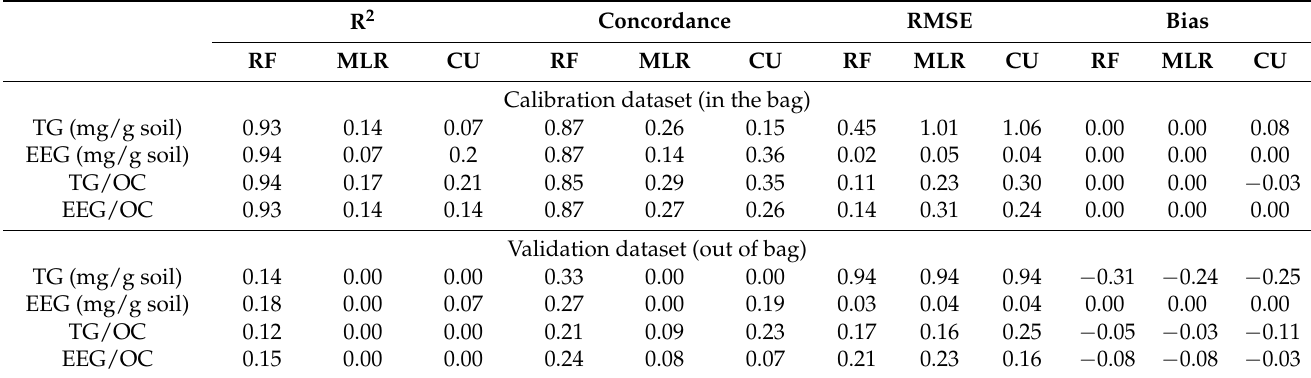
Table 2. The statistical criteria for evaluating the performance of predictions in calibration and validation datasets across the study area as a result of 200